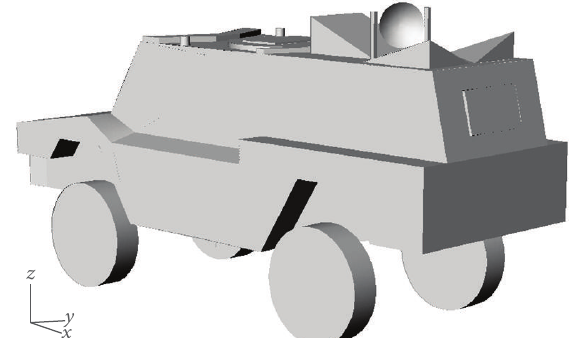
Figure 29: Polar component obtained with MoM and GTD, cut in phi = 0.